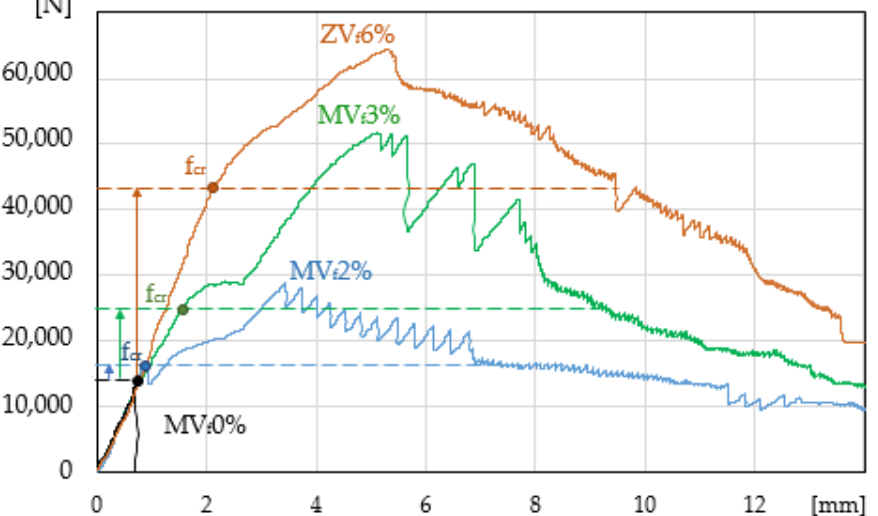
Figure 8. Load-deflection curve in the four-point bending test, comparison of samples. Materials 2020 , 13 , x FOR PEER REVIEW